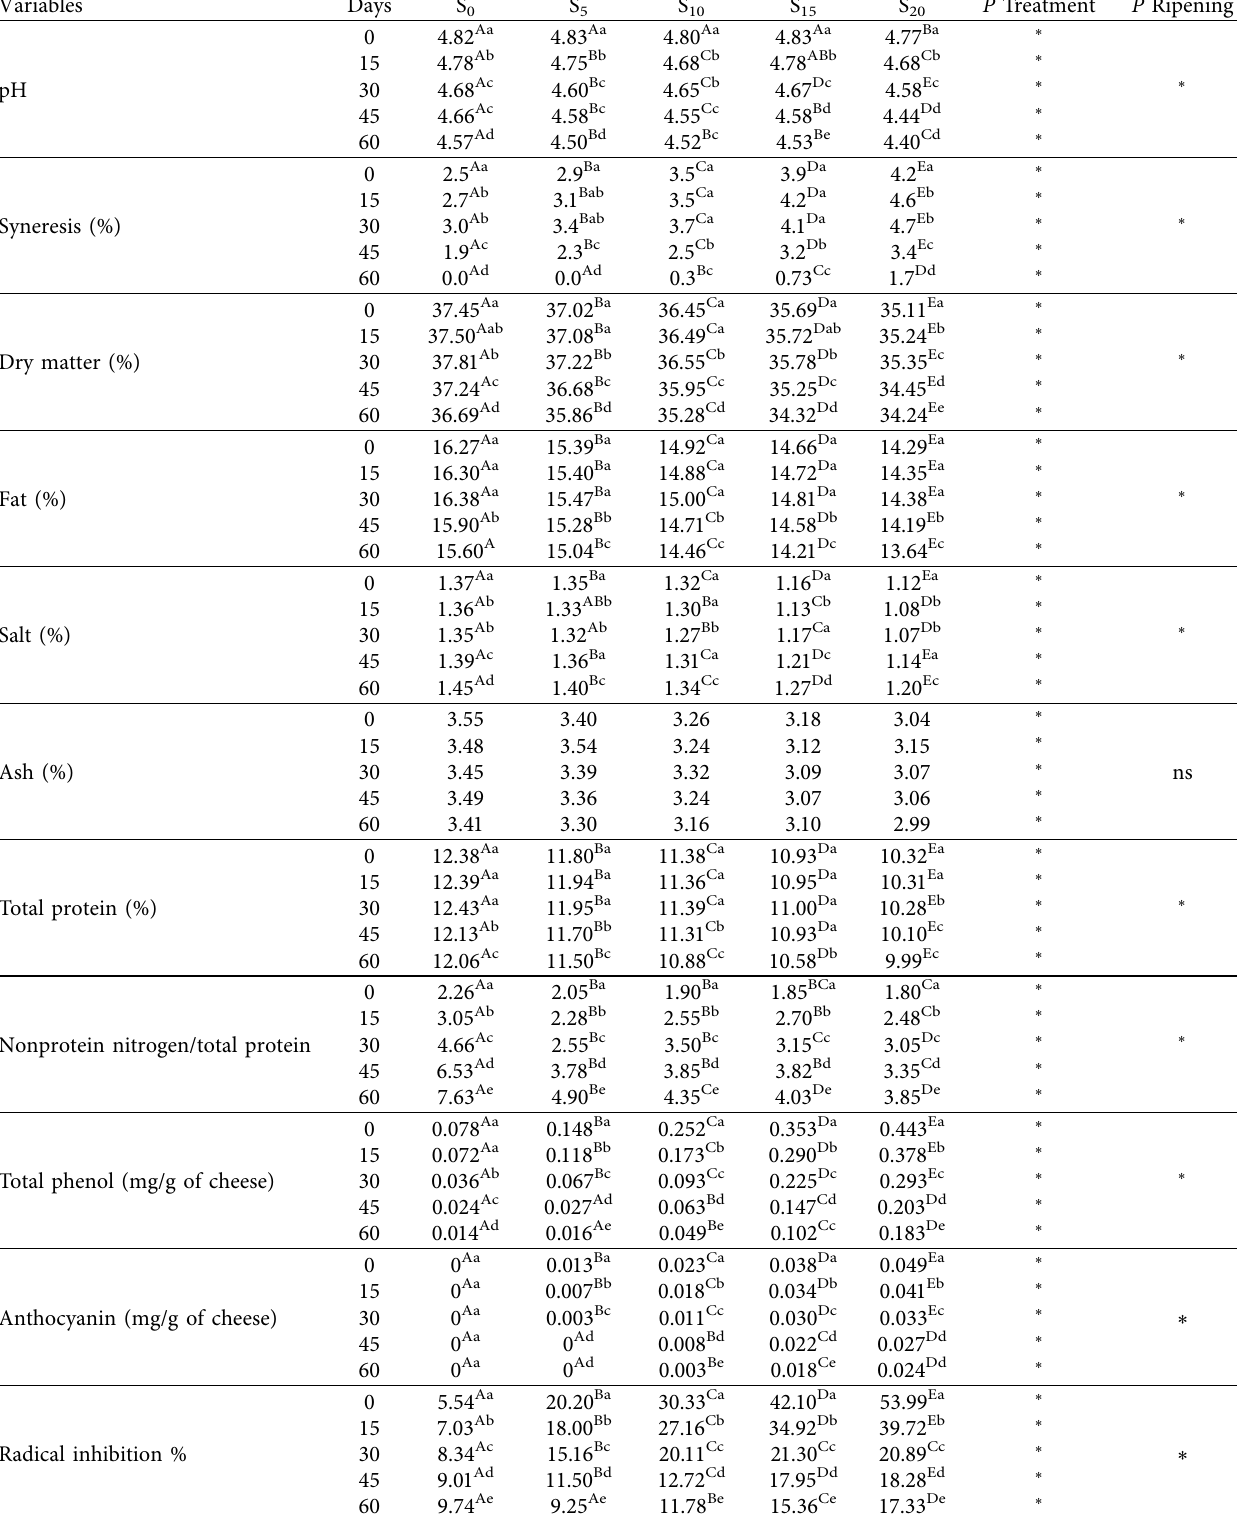
Table 5: The physicochemical properties of Fruit whey less Feta-type cheeses produced using different percentages of pomegranate juice (S S 5 , S 10 , S 15 , and S 20 , respectively, containing 0, 5, 10, 15, and 20% of pomegranate juice).